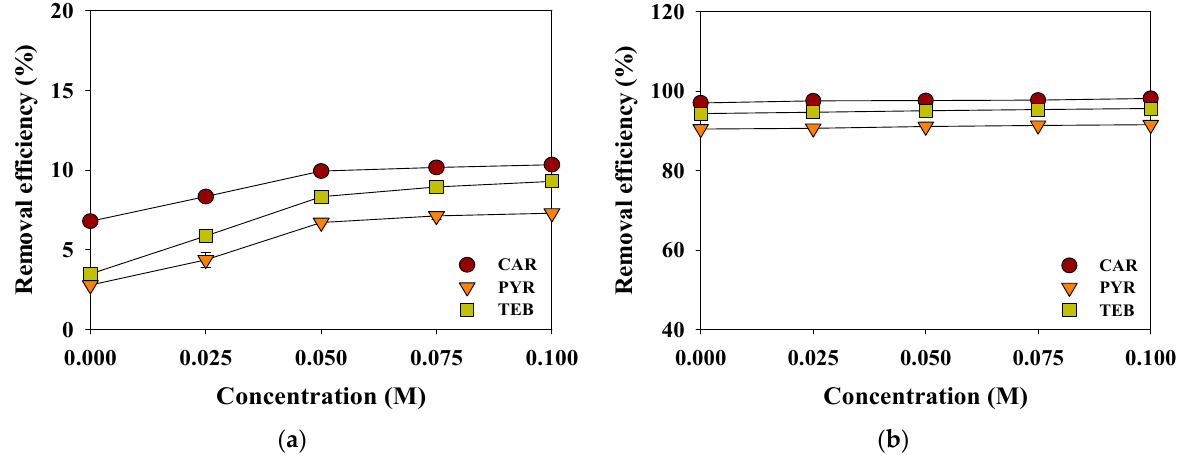
Figure 9. Effects of NaCl concentration on the adsorption of fungicides by ( a ) PSB and ( b ) PSB OX-A (agitation speed = 150 rpm; contact time = 24 h; absorbent dosage = 50 mg L − 1 ; initial concentration of each fungicide = 10 μ M; temperature = 25 °C; pH = 7.0).